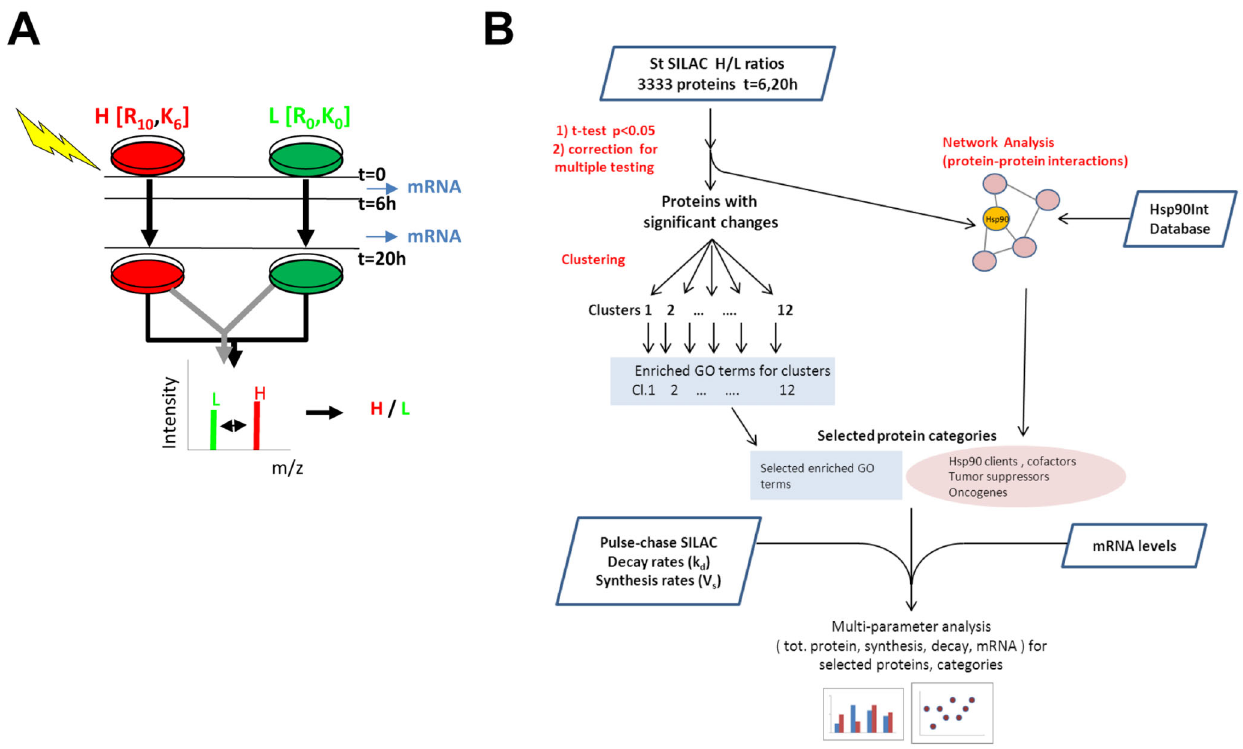
Figure 1. stSILAC experiments and workflow for data analysis. A ) Labelling and sample preparation scheme. Geldanamycin or DMSO were added at t=0. Total protein extracts were collected at t=6h and 20h, while total mRNA was taken at t=5h and t=19h. B ) Data analysis and interpretation combined data on protein abundance changes (stSILAC) with protein-protein interactions (PPI) analysed as a network, synthesis and decay values for proteins in the two conditions and transcript levels. Enrichment of Gene Ontology annotation terms was used to extract functional information on protein categories with common behaviours.